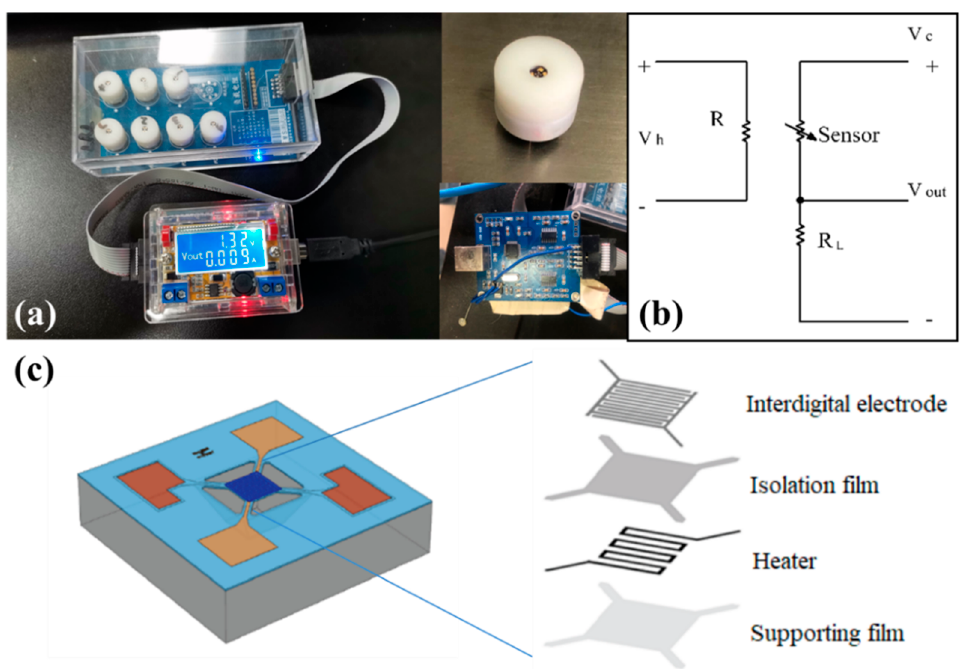
Figure 1. ( a ) Physical diagram of MEMS test platform, gas sensor and temperature control heating plate ( b ) schematic diagram of heating and test circuit ( c ) components and structure diagram of MEMS chip.